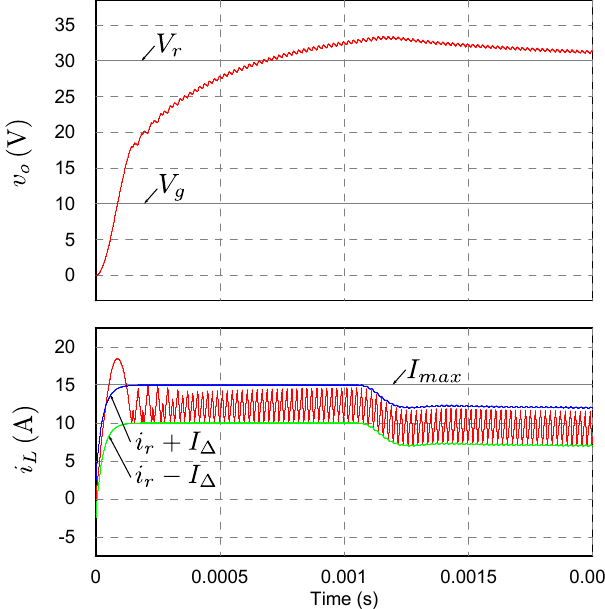
Figure 9. Boost converter response from zero initial conditions using a valley current control at constant switching frequency and voltage